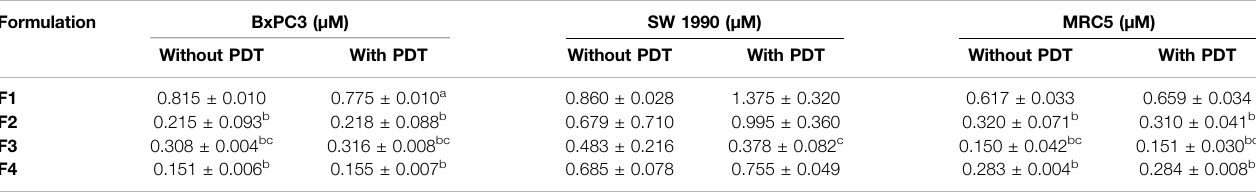
a Indicates statistical signi fi cance compared with F1, with/without PDT ( p < 0.05, student t-test). b Indicates statistical signi fi cance compared with F1 ( p < 0.05, student t-test). c Indicates statistical signi fi cance compared with F4 ( p < 0.05, student t-test).